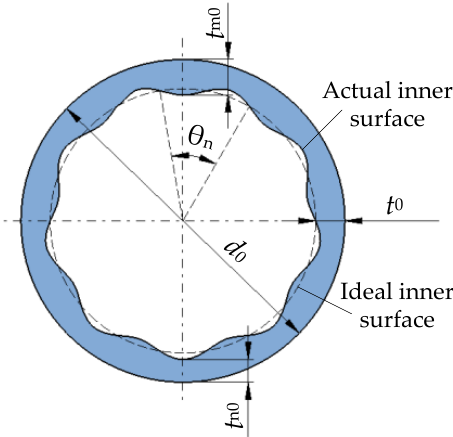
Figure 5. Geometric model of tube with wall thickness deviation.